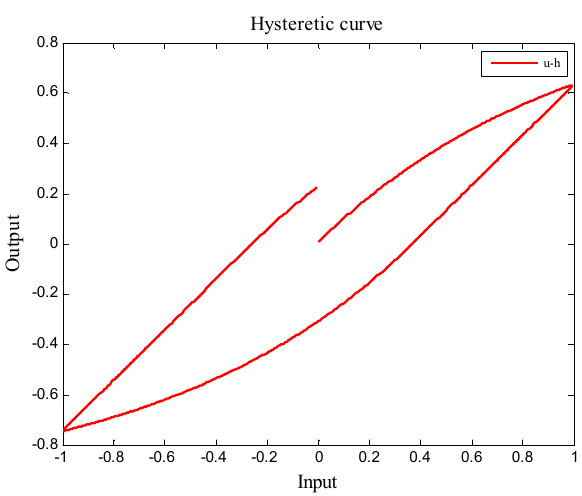
Figure 8. A stable Bouc–Wen model for the piezoelectric materials.